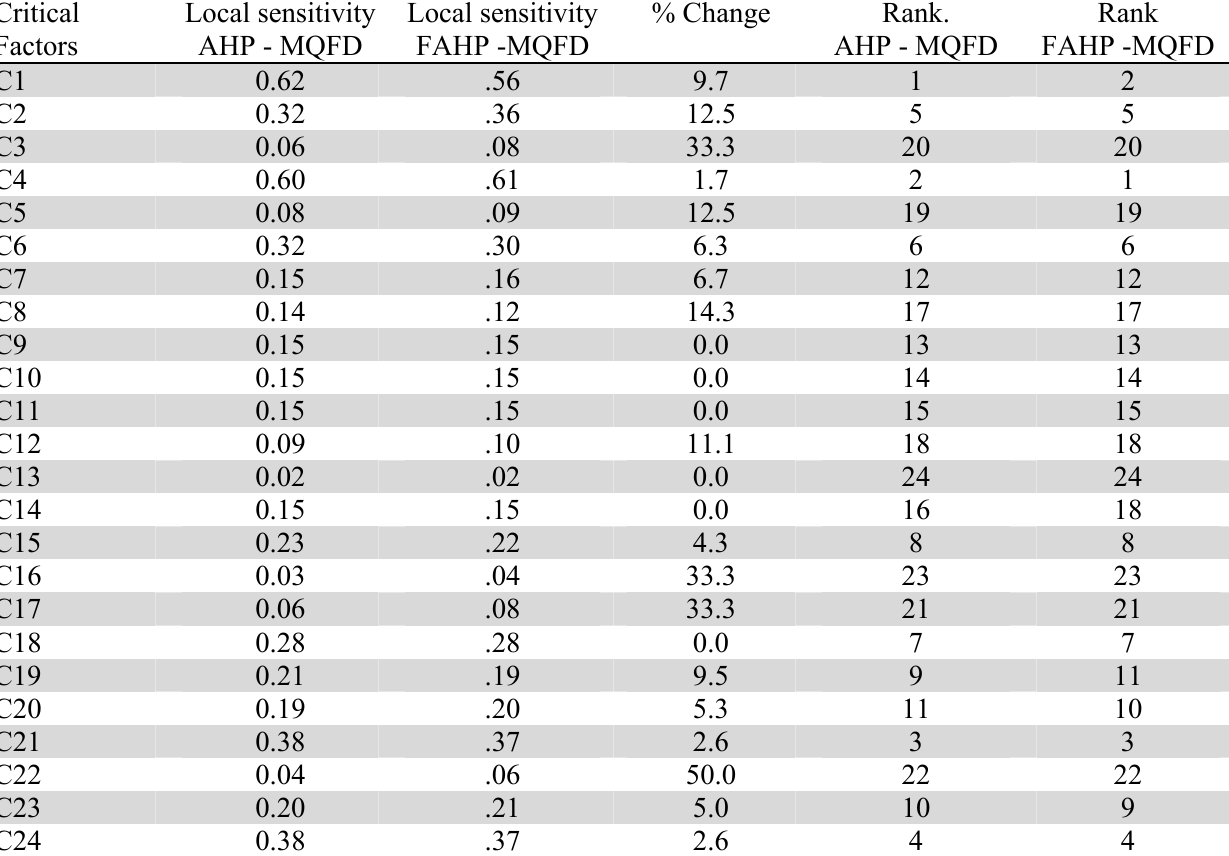
Table 5 Local Weightages of Critical Factors of MQFD model Critical